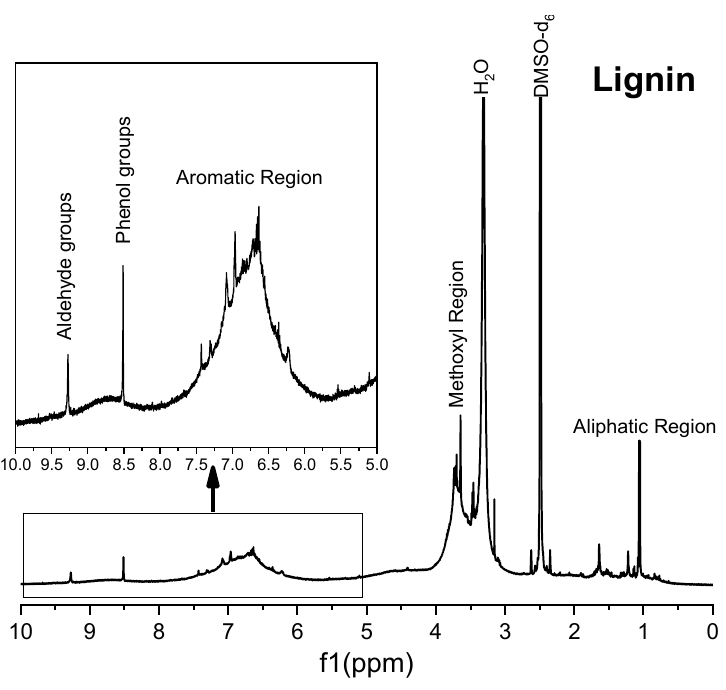
Figure 9. 1 H NMR spectrum of commercial lignin.